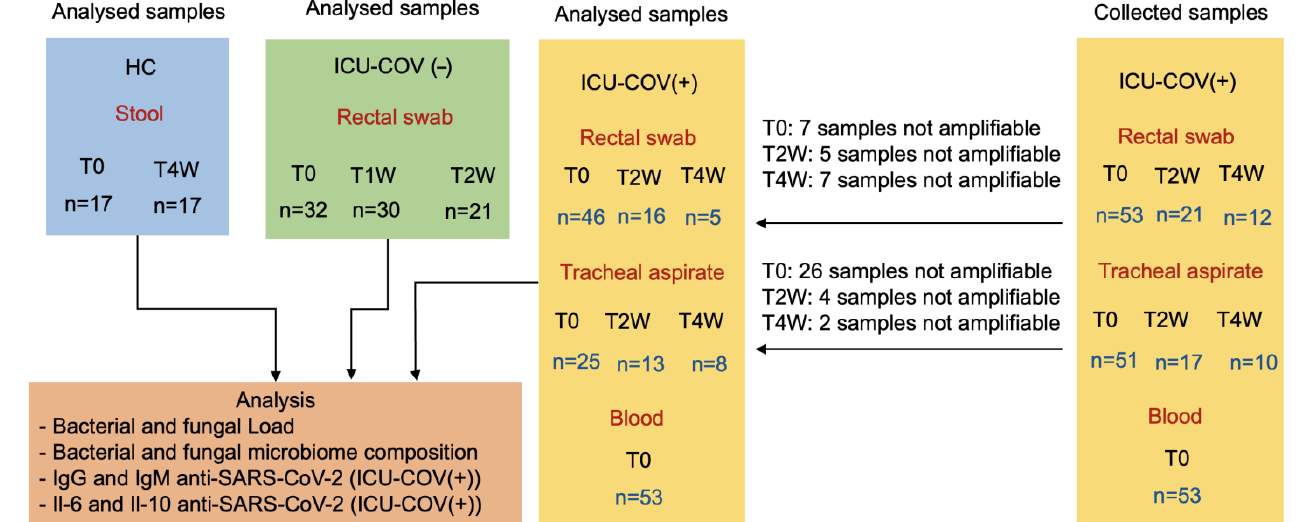
Figure 1. Diagram of participant groups and number of samples collected and processed. The study population consisted of three groups of subjects: 17 HCs, 32 patients admitted to the ICU before the SARS-CoV-2 pandemic (ICU-COV( − )), and 53 patients with COVID-19 admitted to the ICU (ICU-COV(+)). Fecal samples were collected from HCs, rectal swabs from all ICU patients, and tracheal aspirates and blood from ICU-COV(+) patients. HCs and ICU-COV(+) patients were monitored for up to 4 weeks and ICU-COV( − ) patients were monitored for up to 2 weeks. The reason the number of samples decreased over time was that the patients were either discharged or deceased before their samples were collected, and the reason the number of samples analyzed is lower than those collected was that some samples were not amplifiable by